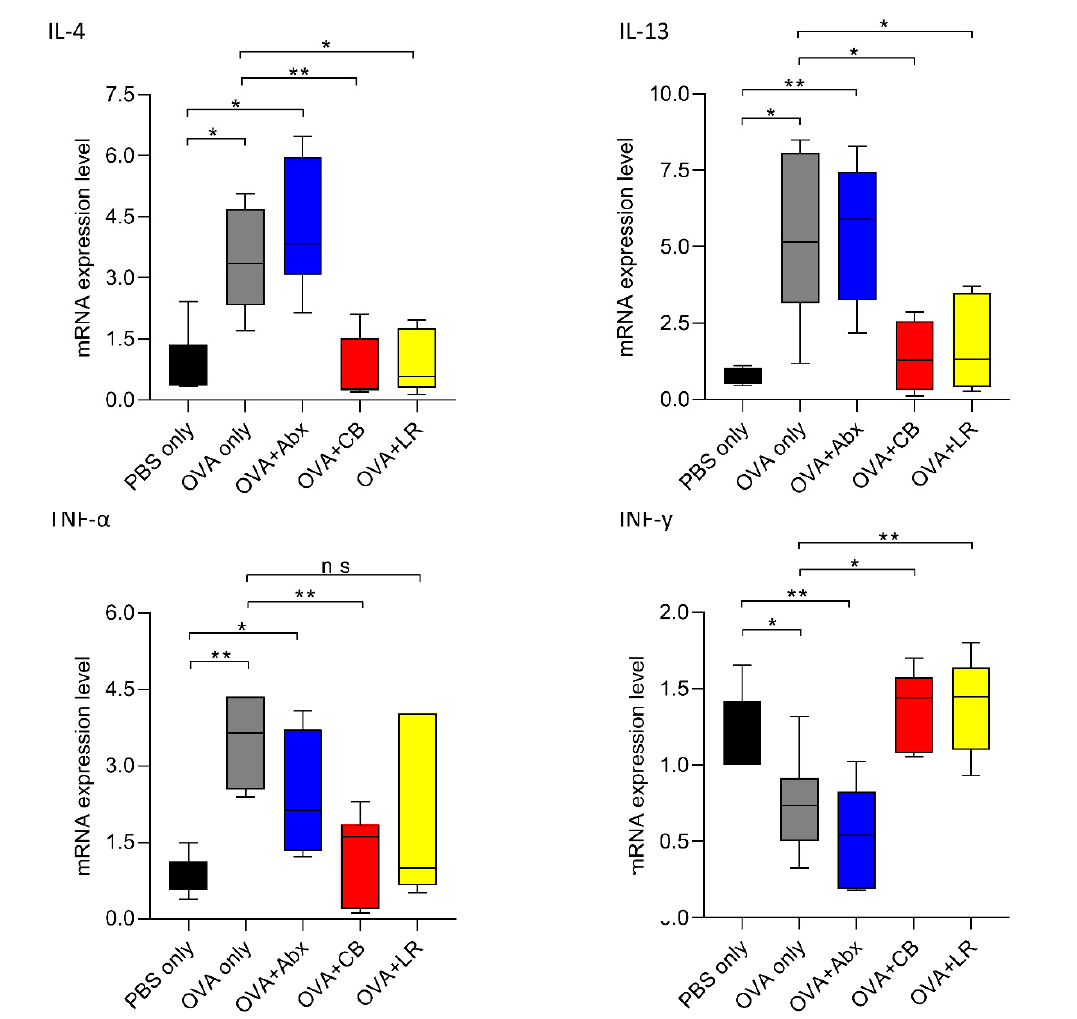
Figure 7. Total RNA was extracted from the jejunal tissue of rats, and the mRNA expression of Th2 and inflammatory cytokine were examined by real time PCR. Data are presented as the fold change in gene expression relative to the control (PBS only). Interleukin (IL)-4, IL-13, tumor necrosis factor (TNF)- α , and interferon-gamma (INF- γ ). Each value is represented as the mean ± SEM ( n = 5–7 rats per group). Boxes represent the 25th to 75th percentiles; middle bar identifies the median; whiskers show the minimum and maximum ( n = 5–7 rats per group). * p < 0.05, ** p < 0.01 determined by ANOVA with the Tukey–Kramer method. ns, no significance; Abx, antibiotics; CB, C. butyricum ; LR, L. reuteri.